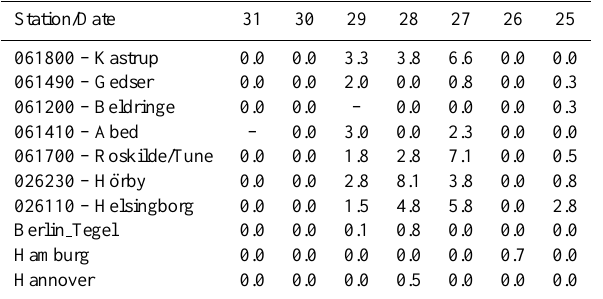
Table A2a. Daily measured precipitation in mmday − 1 in the poten- tial source region to the episodes of Alternaria spore concentrations (sporesm − 3 ) that were measured 30–31 August 2008. The last 7 days of recorded precipitation until the potential episode is used as an indicator of good harvesting possibilities. “–” usually means no precipitation was recorded, but could potentially also mean techni- cal problems.